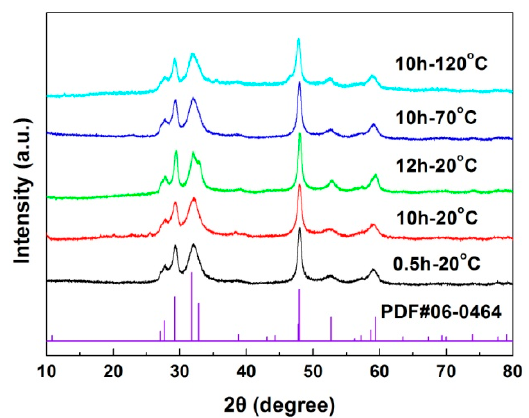
Figure 3. X-ray powder diffraction (XRD) patterns of CuS samples synthesized at different temperatures with different reaction times.